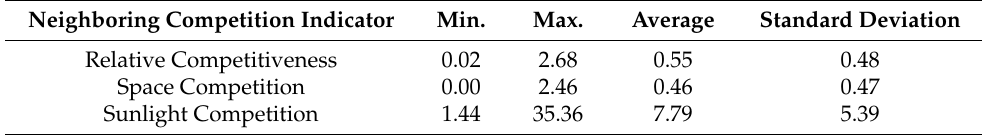
Table 3. Descriptive statistics of neighboring competition indicators ( n = 218). Neighboring Competition Indicator Min.